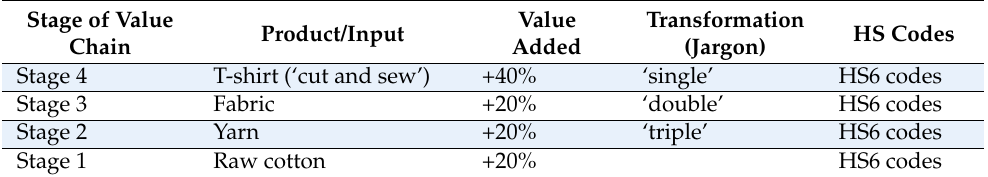
Table 3. Representations of substantial transformation options for apparel in the form of descriptive words, value-added, and HS